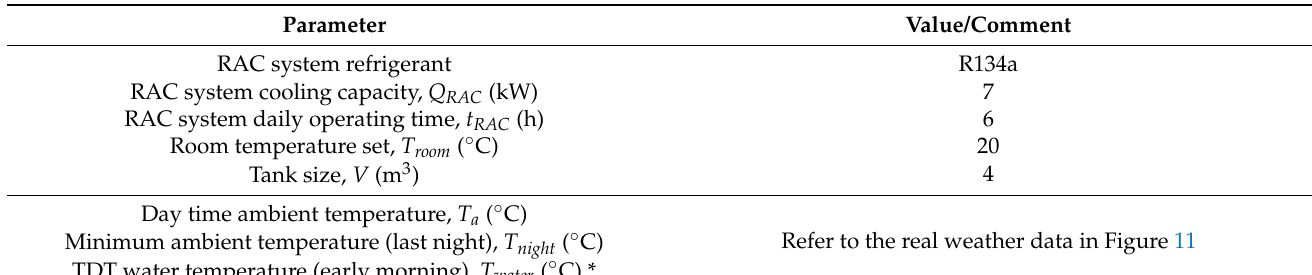
Table 3. Characteristics of the TDT-RAC system used in the case